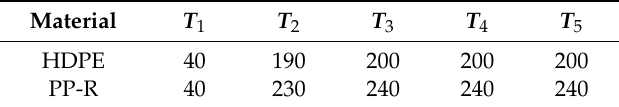
Table 2. Temperature profiles in °C.